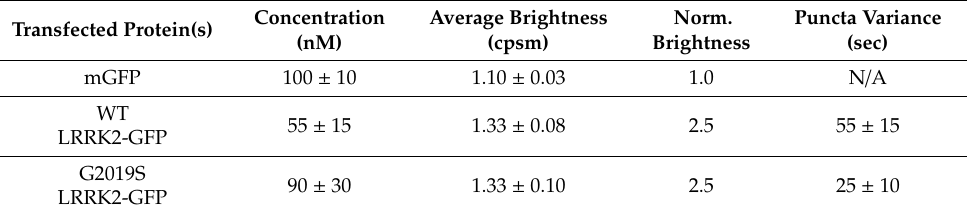
Table 2. TIRF fluctuation analysis of plasma membrane-associated LRRK2-GFP. Concentration Average Brightness Norm. Puncta Variance Transfected Protein(s) (nM) (cpsm) Brightness